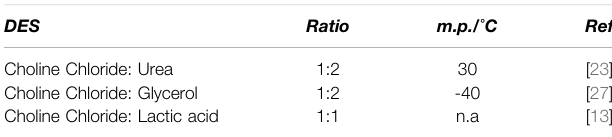
TABLE 1 | Molar ratios and melting points for the three DES systems. DES Ratio m.p./ °